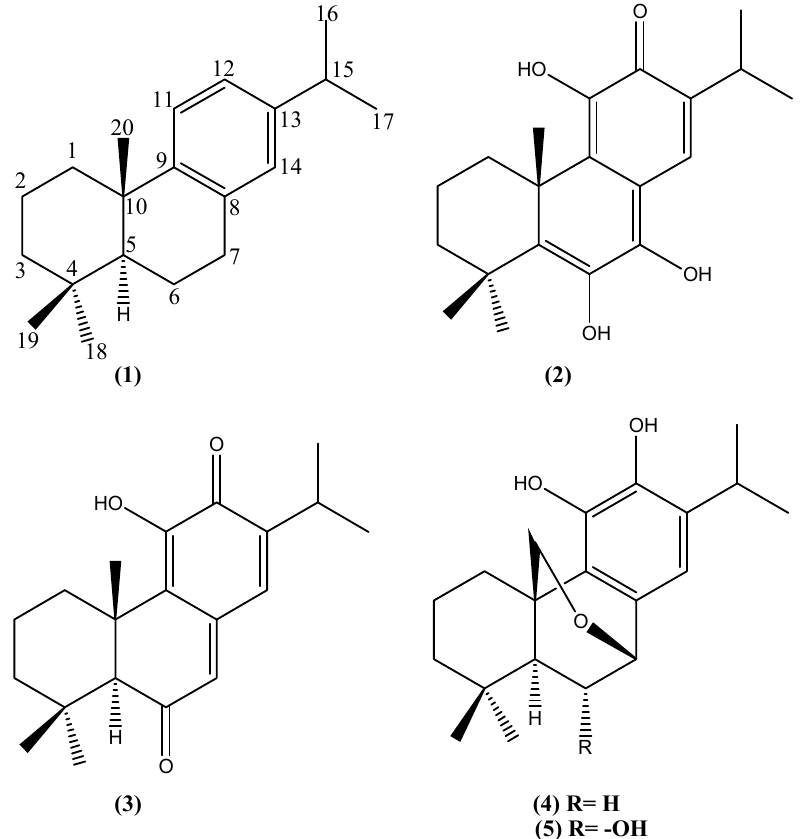
Figure 1. Chemical structures of the isolated abietane diterpenes from P. barbatus